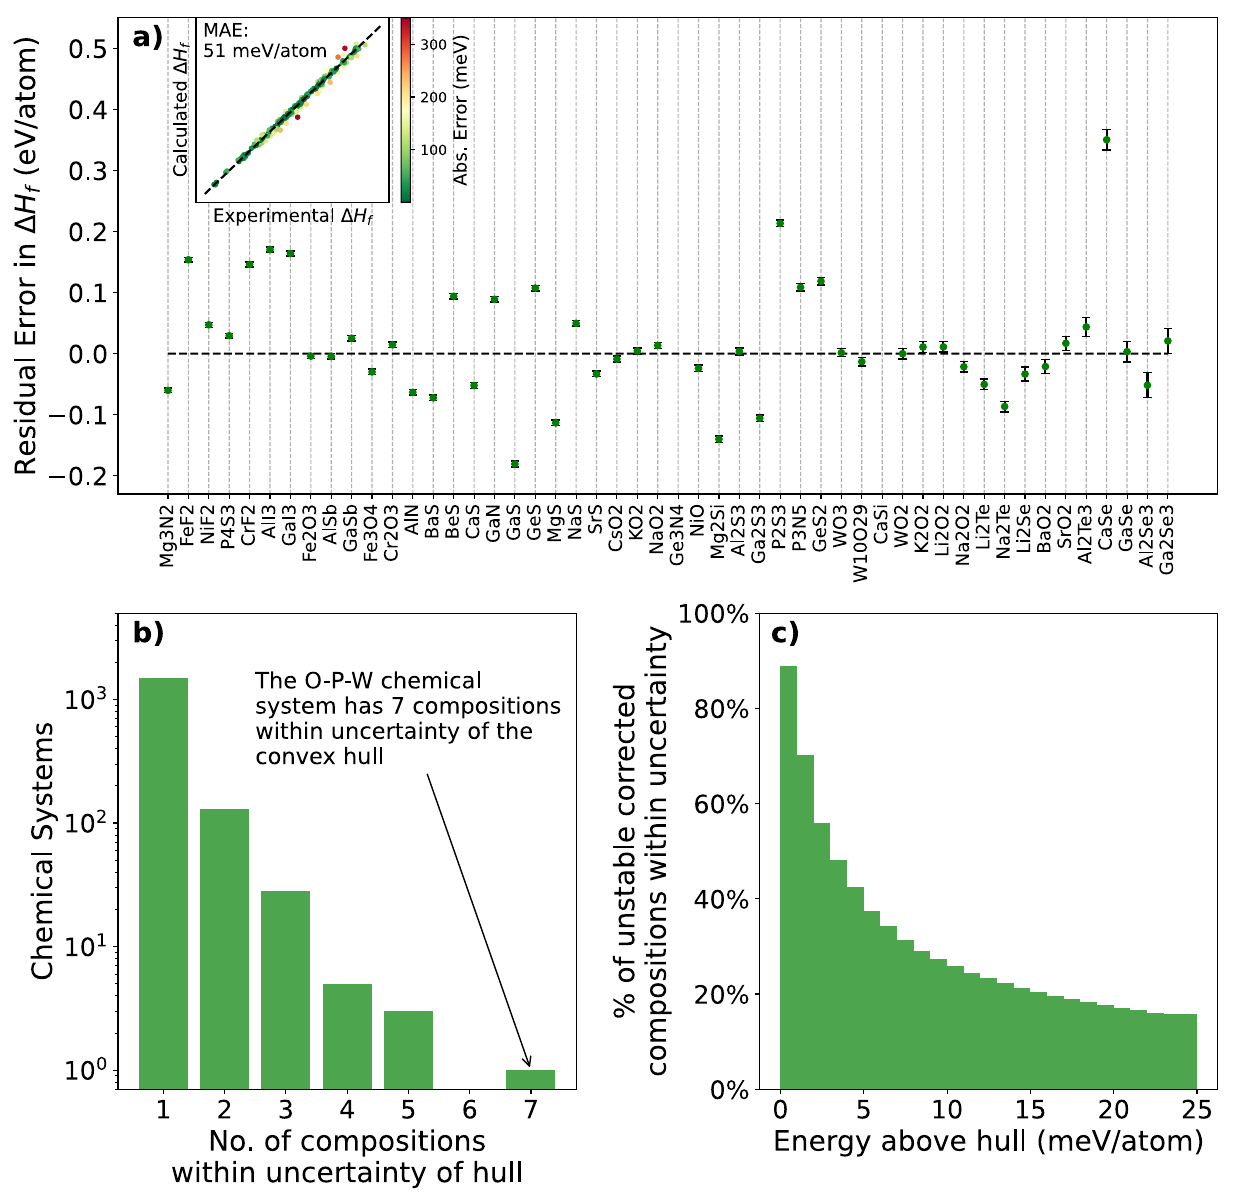
Figure 1. Fitted energy corrections and uncertainties. ( a ) Residual error in calculated formation energy o ,298 K , expt − (cid:31) H o ,298 K , DFT ( (cid:31) H f f ) for the 50 compounds with the largest fit uncertainty, which is indicated by the error bars. Compounds are sorted by increasing fit uncertainty such that the highest fit uncertainties are listed on the right hand side of the plot. Inset: calculated and experimental formation energies for the entire dataset after fitting the corrections. The dashed line indicates perfect agreement. ( b ) Number of chemical systems in the Materials Project database 26 that contain unstable phases within fit uncertainty of the ground-state energy